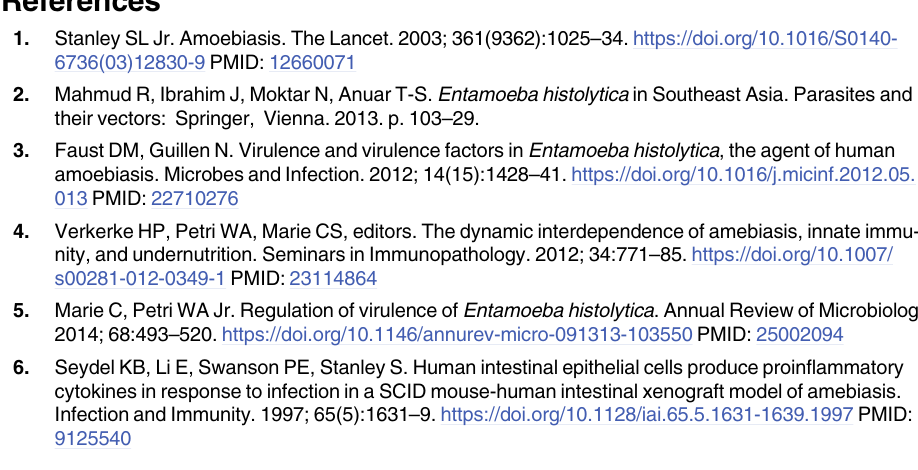
S8 Fig. IL-1 β release during Eh -macrophage contact was independent of cullin-1/5. (A, B) THP-1 macrophages silenced for cullin-1/5 siRNA was incubated with Eh or LPS for 2h and pro-inflammatory cytokine (IL-1 β ) levels measured using human cytokine array pro-inflam- matory focused 15-plex discovery assay. Data are representative of three independent experi- ments and statistical significance was carried out with Student t test.